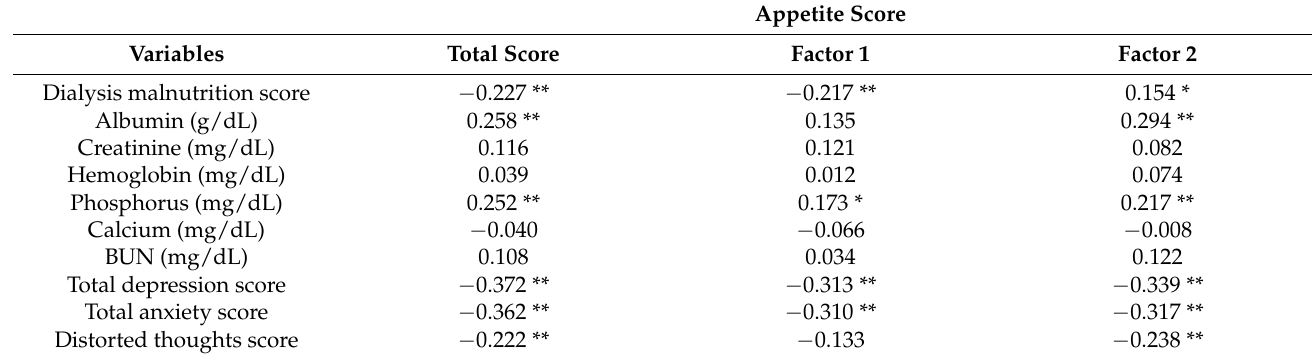
Table 3. Spearman’s correlation analysis between the appetite score, malnutrition variables, and psychological variables ( n =